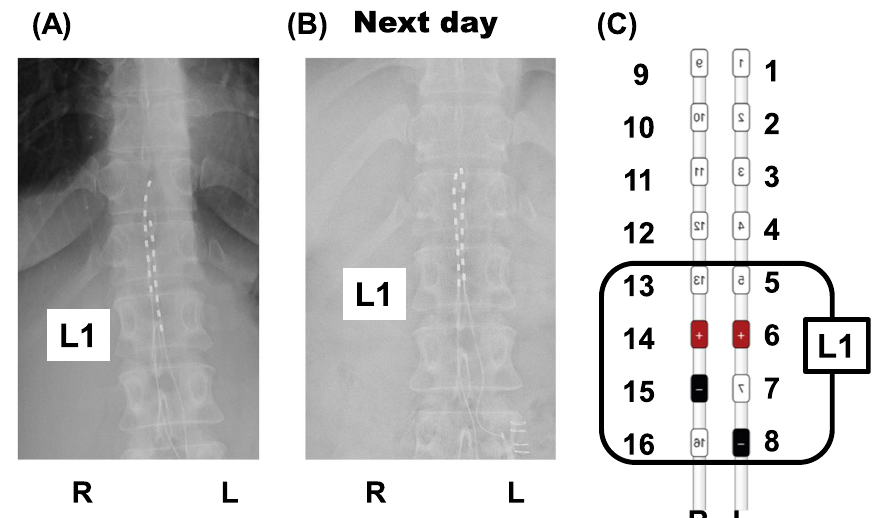
Fig. 2 The two permanent lead positions. A Plain X-ray front view on the operation day. B Plain X-ray front view day after the operation. C An enlarged schematic view of the stimulation site. Finally, electrodes number 6, 8, 14, and 15, which correspond to the L1 level on both sides, were used for stimulation. R, right side; L, left